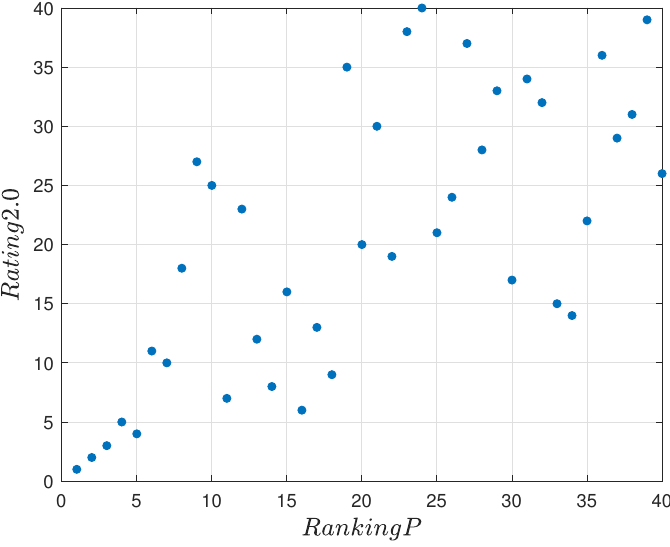
Figure 26. The relation diagram of the final ranking ( P ) for reference ranking Rating